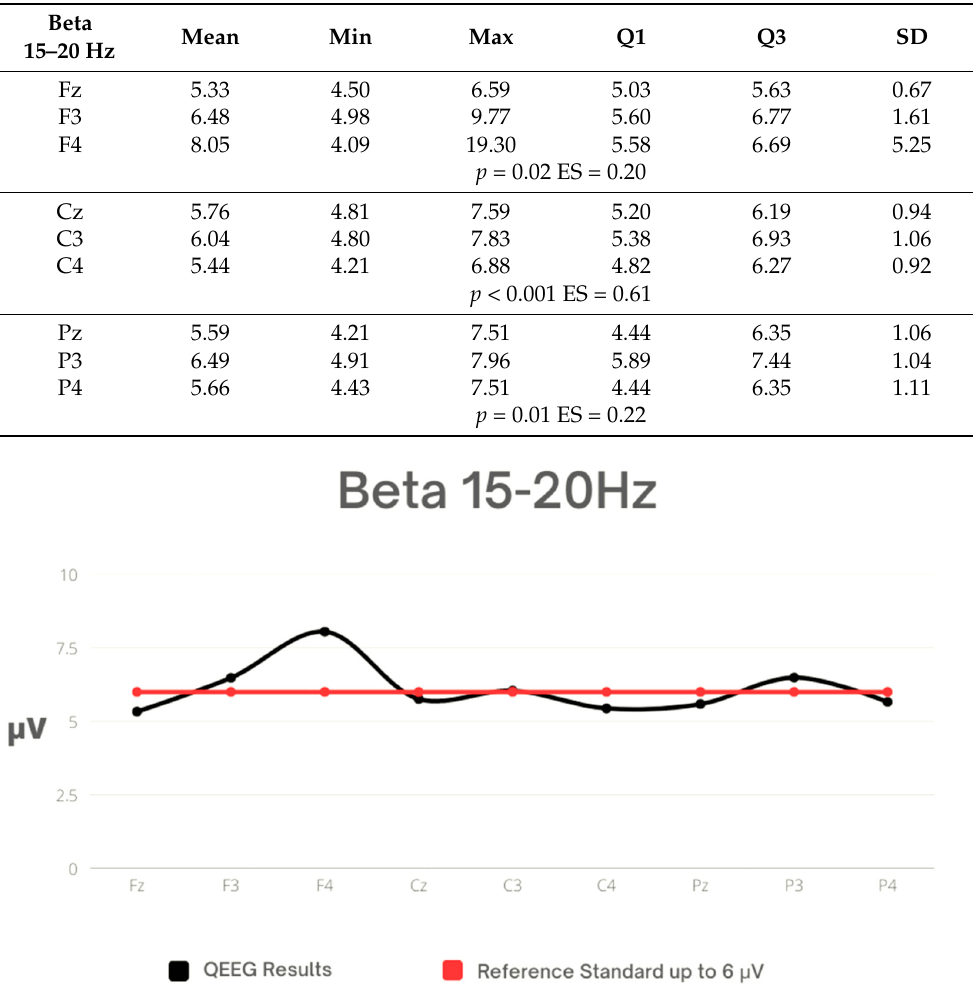
Figure 5. Mean values for Beta 1 against the reference standard.